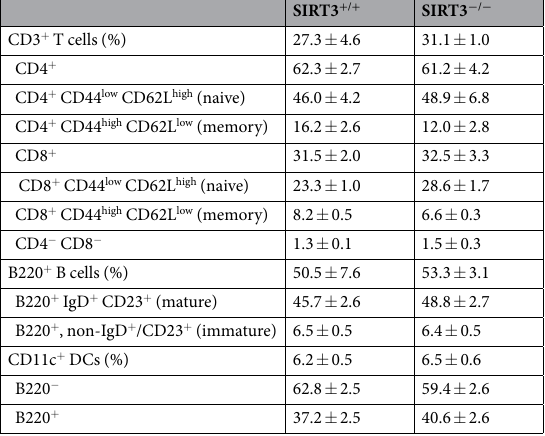
Table 2. Splenic cell subsets in SIRT3 + / + and SIRT3 − / − mice. Data are means ± SD of 4 animals per group and expressed as the percentage of CD3 + , B220 + , and CD11c + splenic cells or the percentage of the CD3 + , B220 + and CD11c + parental populations expressing CD4, CD8, CD44, CD62L, IgD and CD23. Total cell numbers were 75.1 ± 7.5 and 75.4 ± 21.1 millions per spleen in SIRT3 + / + and SIRT3 − / − mice, respectively. No statistically significant differences in subset’s percentages and absolute numbers were